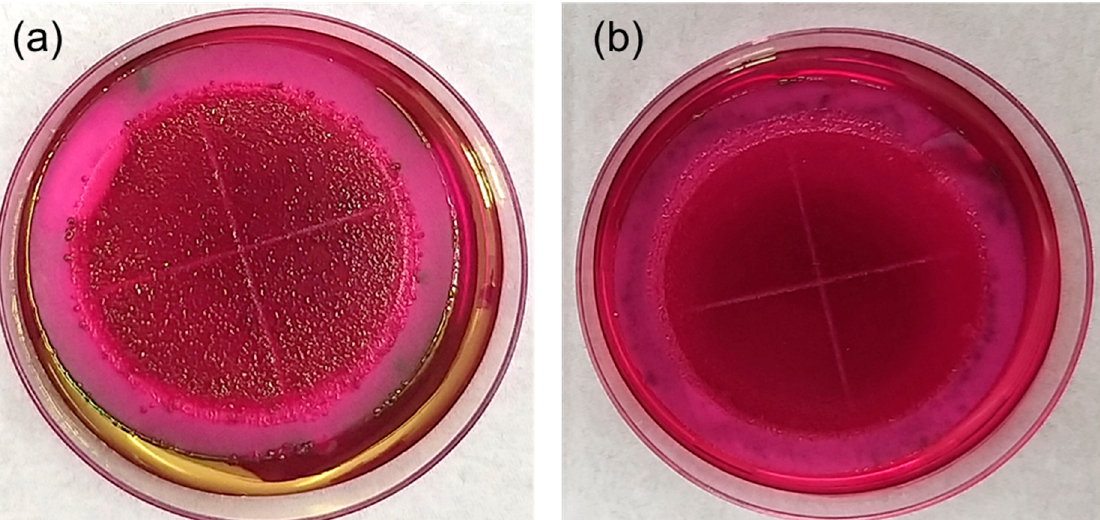
Figure 12. Pictures of petri plates for detection of total coliforms following 24 h incubation at 35 °C ( a ) before water treatment and ( b ) after water treatment with CXTi. The colonies that were dark red, mucoidal and had dark centres were counted. Dark centres that produce metallic sheen are considered to be total coliform colonies. Metallic green colonies indicate the presence of E. coli in a water sample.